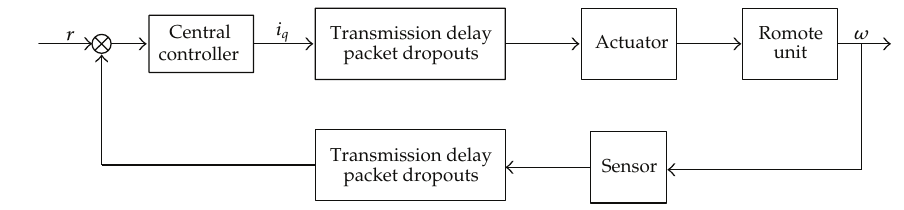
Figure 4: The model of the networked PMSM servo